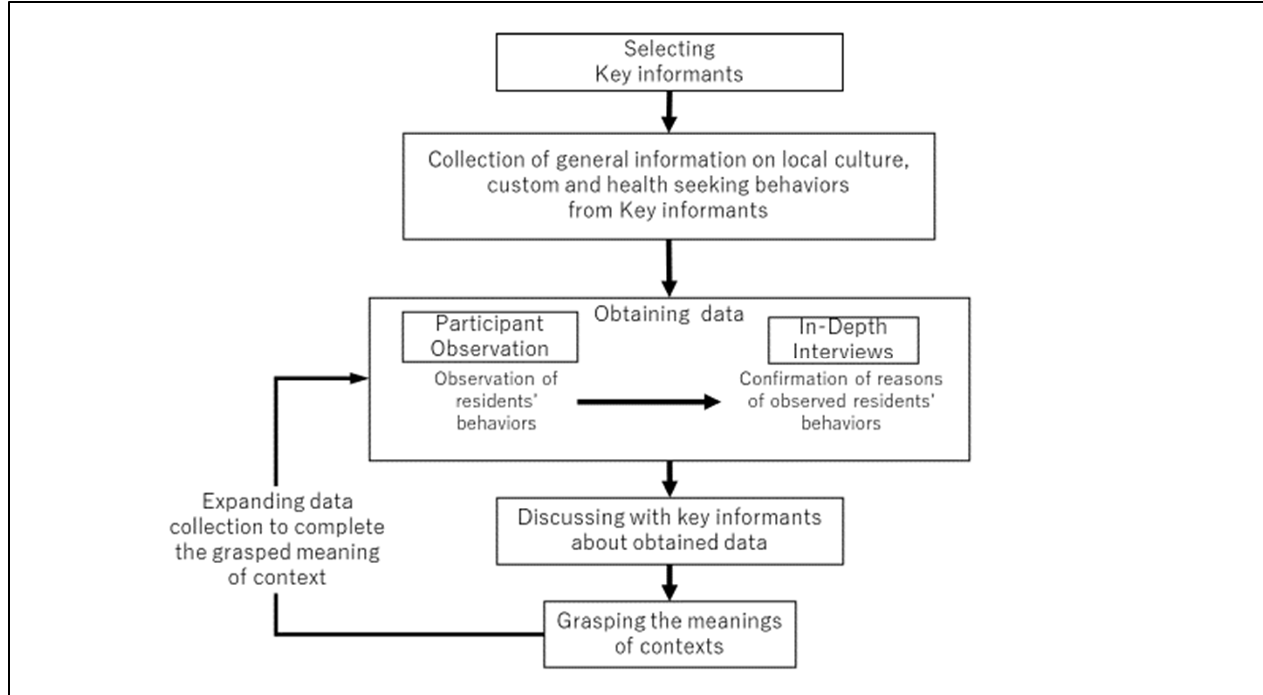
Figure 2. Flowchart for the data collection process.